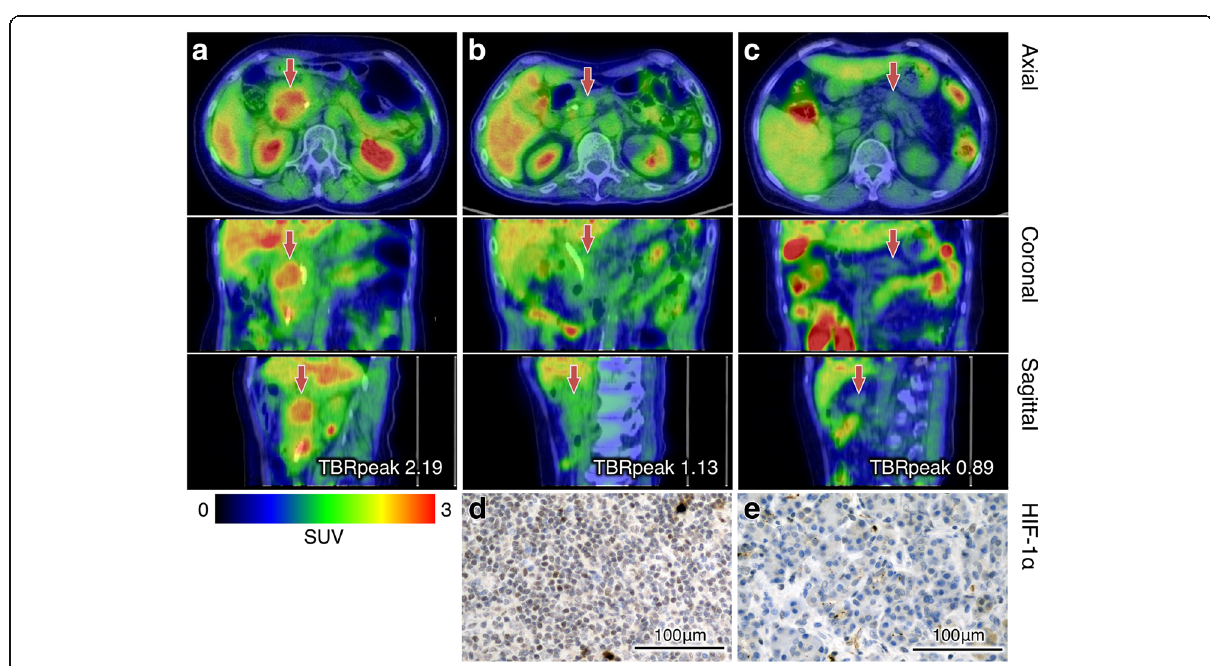
Fig. 2 Representative [ 18 F]FMISO PET/CT images ( a , b , c ) and HIF-1 α immunohistochemical images ( d , e ) of pancreatic cancer. A color bar from 0 to 3 indicates standardize uptake value (SUV) of fused [ 18 F]FMISO images. The first case with increased [ 18 F]FMISO uptake on the primary tumor ( a , arrows) was finally decided as inoperable. The second case with moderate [ 18 F]FMISO uptake ( b , arrows) received operation, and the immunohistochemistry shows strong HIF-1 α expression ( d ). The third case with low [ 18 F]FMISO uptake ( c , arrows) also received operation, and the